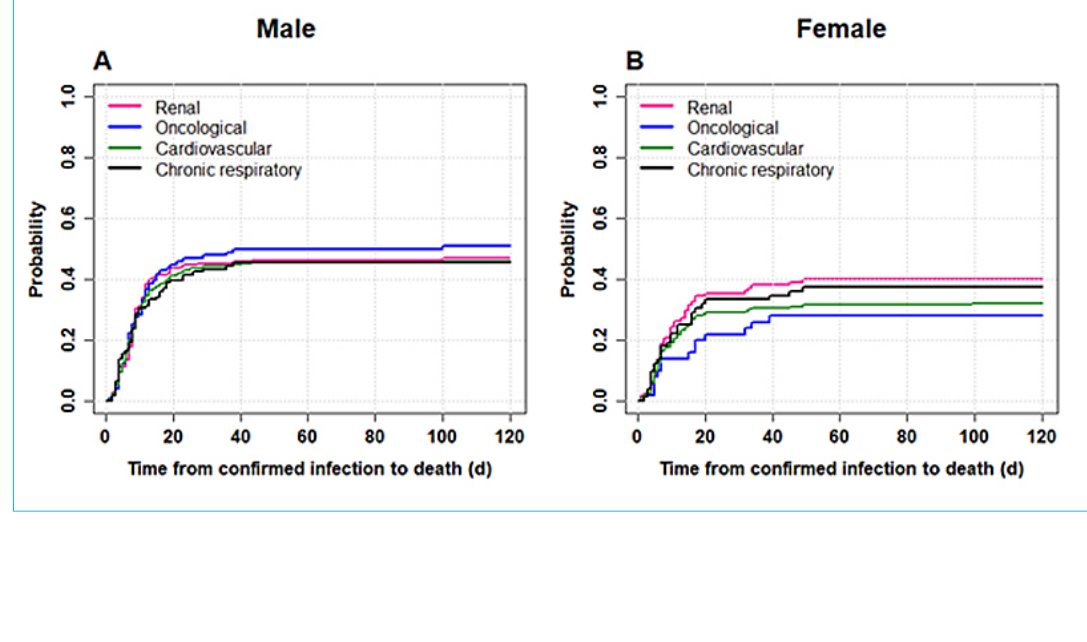
Figure S1: Cumulative incidence of death for patients aged 80+ (panel A male, panel B female) and according to the following comorbidities: renal disease, oncological pathologies, cardiovascular disease and chronic respiratory disease. Data includes patients hospitalised up to